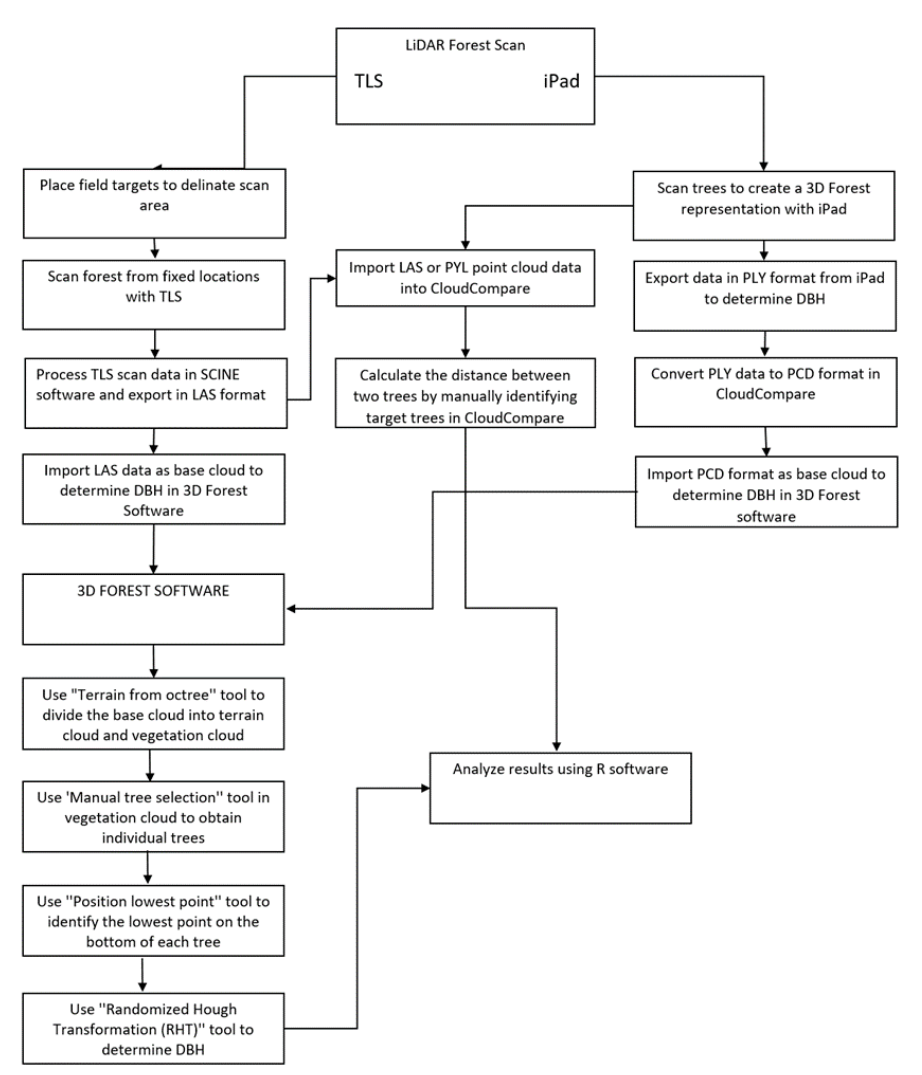
Figure 3. Project workflow.